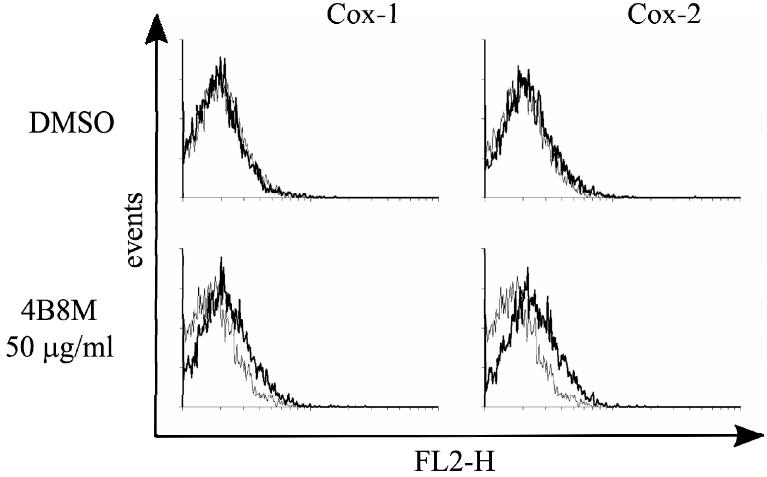
Figure 12. Effect of 4B8M on induction of COX-1 and COX-2 in the human keratinocyte KERTr cell line.